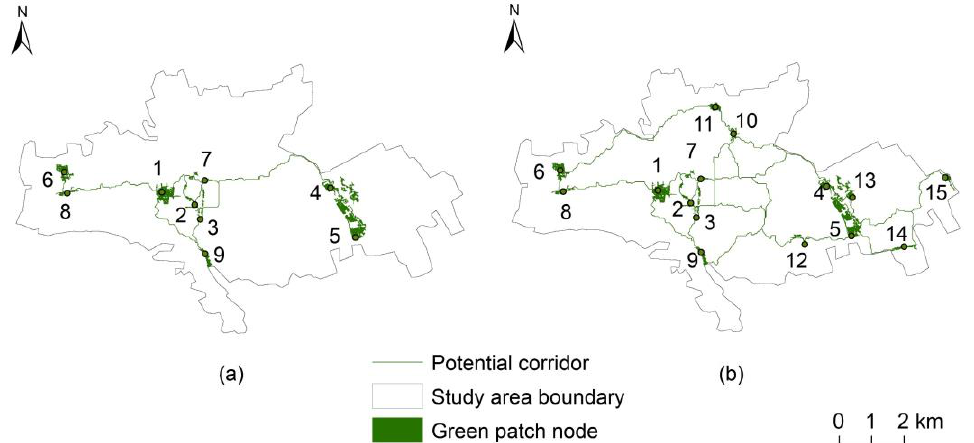
Figure 7. Potential urban green space network based on the least-cost path method: ( a ) recreational corridors; ( b ) ecological corridors. Note: (1) People’s Park; (2) East Lake Park; (3) South Lake Park; (4) Xiao Yalang Wetland Park; (5) Dongcheng Park; (6) West Park; (7) Times Squar; (8) Chalbagh Style Park; (9) Kashgar River; (10) Woodland; (11) Xiangfei Garden; (12) Shade belt; (13) Woodland; (14) Kashgar University; (15) Shang Yalang Reservoir.